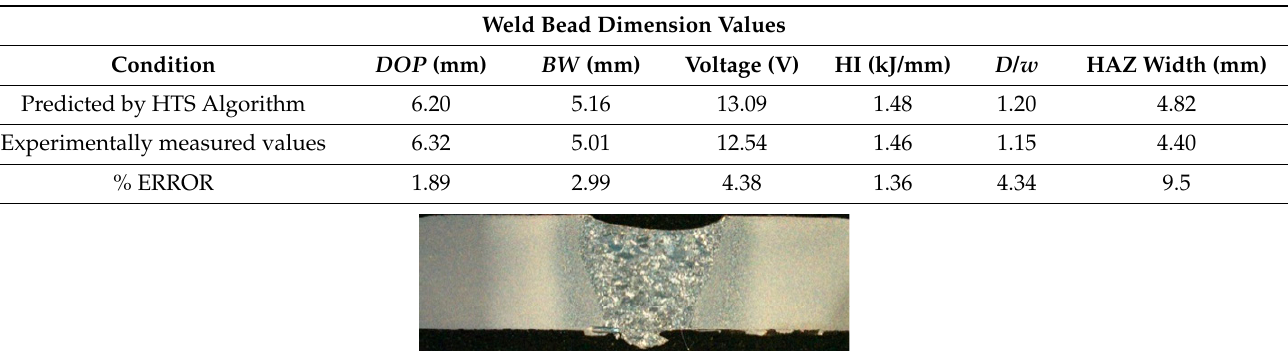
Figure 4. Predicted values (by generated models) vs. actual values (experimentally measured) for ( a ) DOP , ( b ) HI, ( c ) Aspect ratio, ( d ) HAZ width. Table 8. Validation results for case study Table 8. Validation results for case study 2.